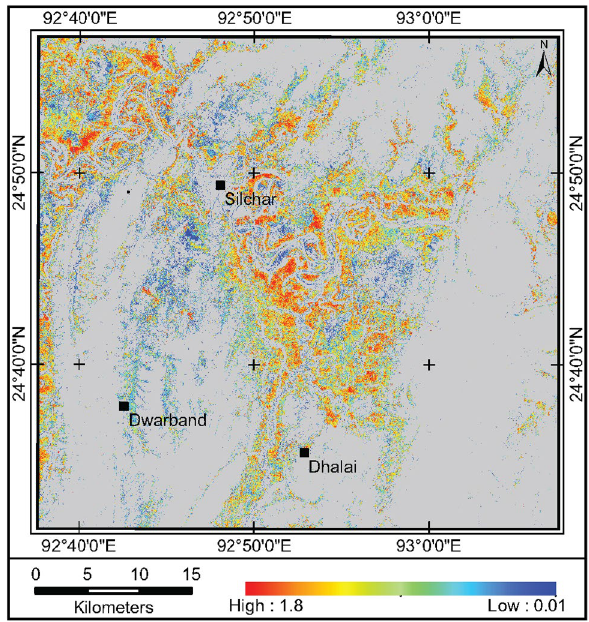
Fig. 9 Band ratio image 7/5 indicating clay and carbonate mineral abundance areas as low values (shades of lighter gray regions repre- sent areas of thick vegetation/water